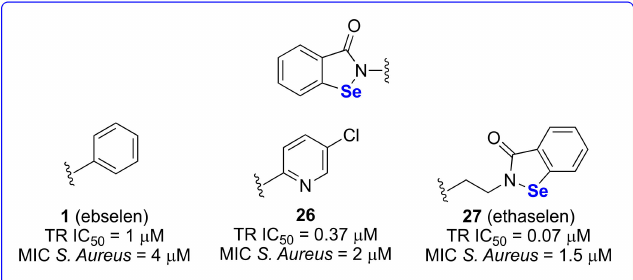
Figure 3. Antibacterial TR